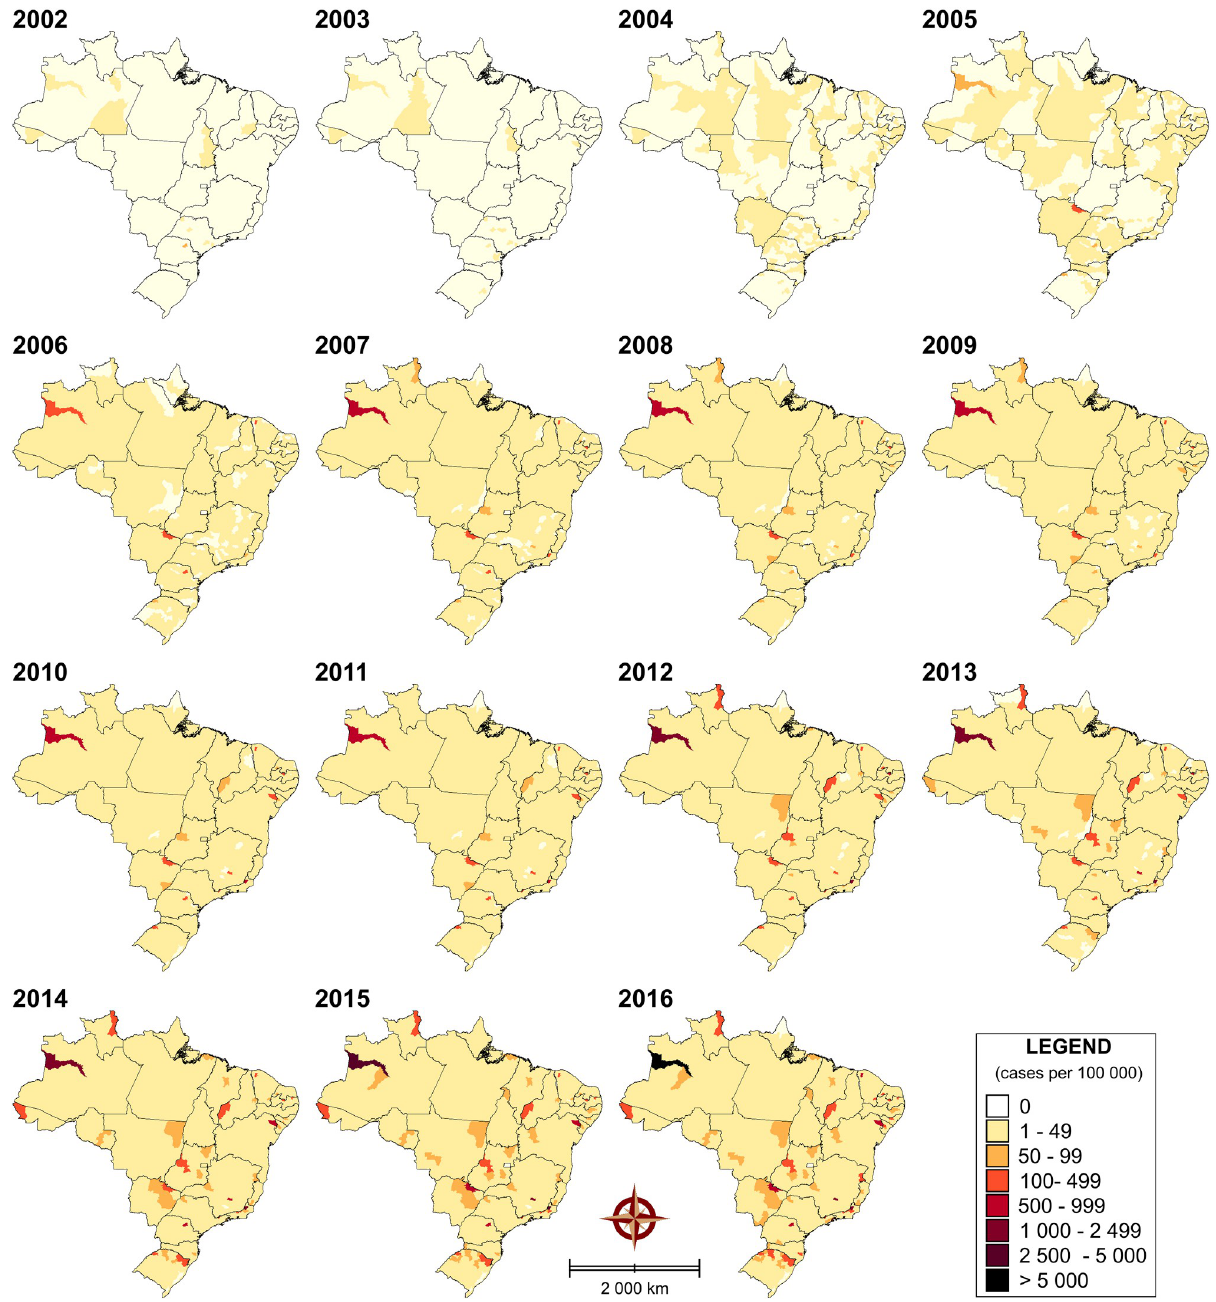
Fig 6. Spatiotemporal distribution of SiP cases (2001 to 2017) in Brazil, based on cases by microregions. Digital maps in the public domain (publicly available) were obtained from IBGE cartographic database in shapefile format (.shp), which was subsequently reformatted and analyzed using QGIS version 3.10. Authors specify that this figure is licensed under CC BY